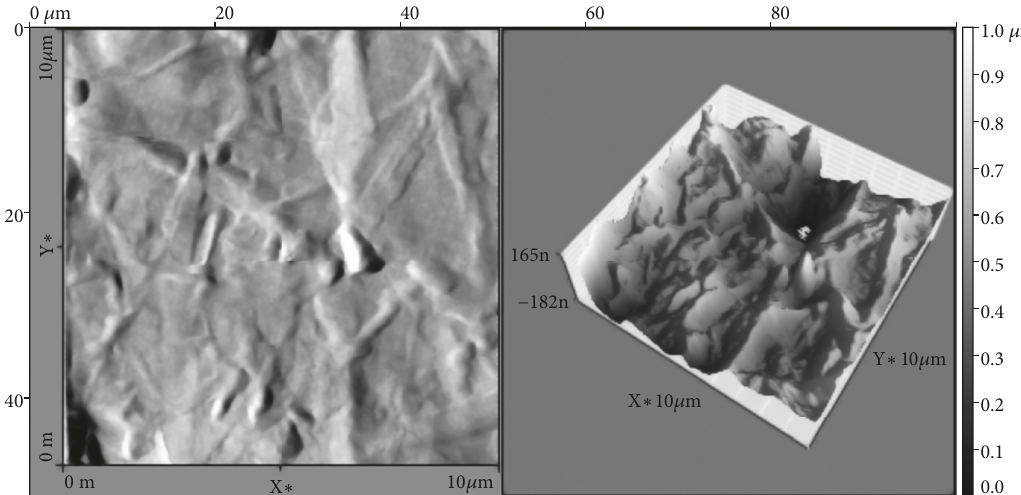
Figure 8: AFM image and three-dimensional topography of commercially purchased graphene coated aluminum . Again, graphene flakes are easily seen in the two-dimensional AFM image on the left. These images were taken using the DD-ACTA